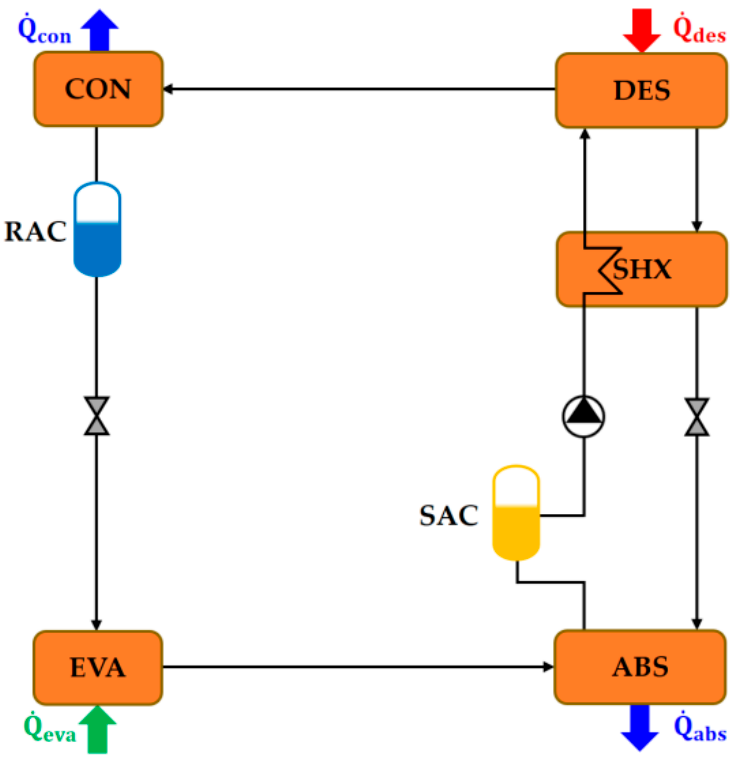
Figure 16. Single ‐ lift (single ‐ effect) ammonia/water absorption cycle of the University of Innsbruck Figure 16. Single-lift (single-e ff ect) ammonia / water absorption cycle of the University of Innsbruck prototype. Adapted from Reference [77]. Note: ABS=absorber; CON=condenser; DES=desorber; prototype. Adapted from Reference [77]. Note: ABS = absorber; CON = condenser; DES = desorber; EVA=evaporator; RAC=refrigerant accumulator; SAC=solution accumulator; SHX=solution heat EVA = evaporator; RAC = refrigerant accumulator; SAC = solution accumulator; SHX = solution exchanger. heat